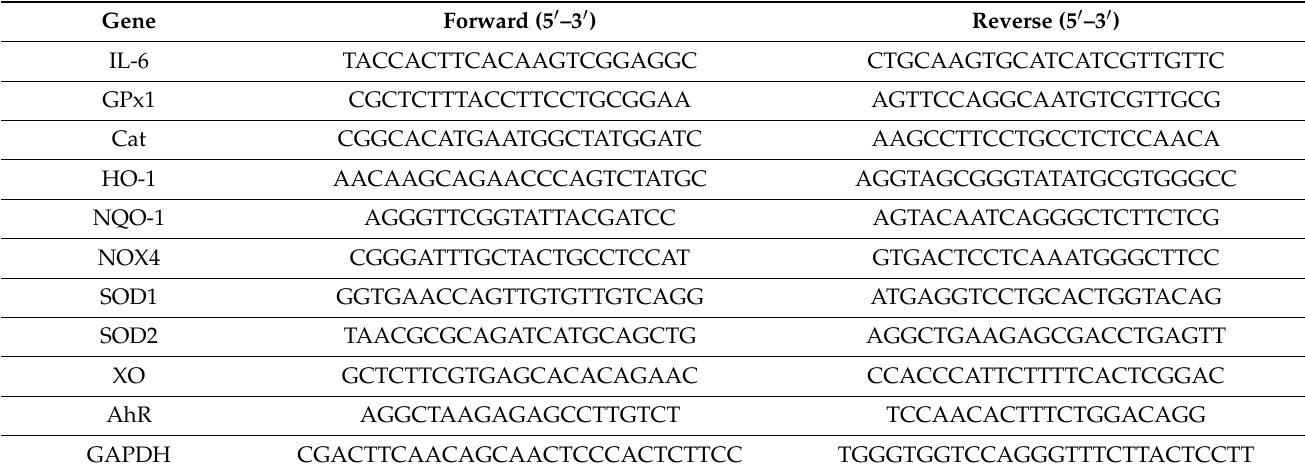
Table 1. The primer sequences for each